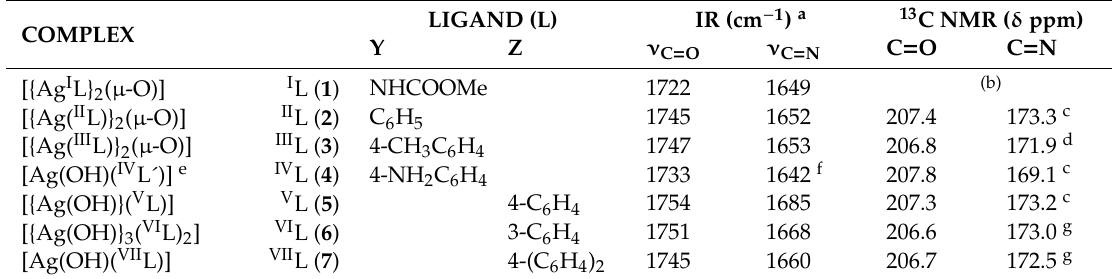
Table 1. Complexes obtained from reaction of Ag(OAc) with camphor ligands (L).